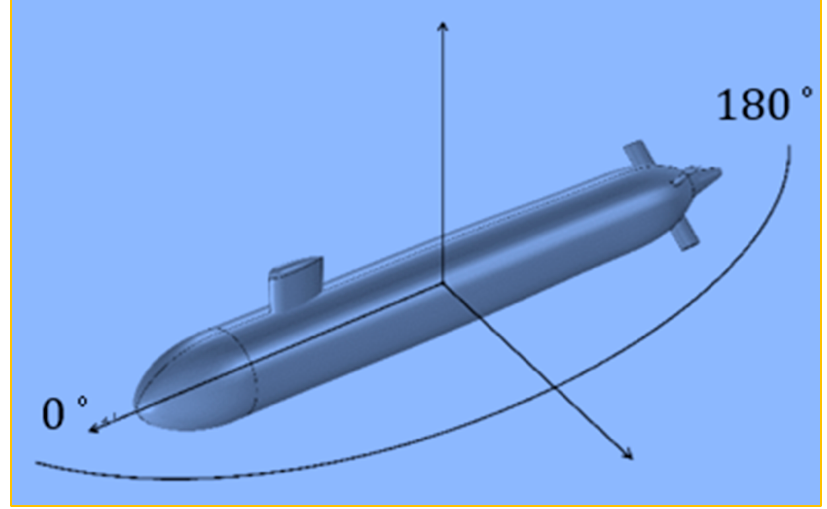
Figure 2. The simulation’s zoomed-out view of the target’s vitality and its sweeping angle. Target strength was calculated using the Helmholtz–Kirchhoff Integral [26,27] and the finite element technique (FEM) for the acoustic–solid coupled model. Target strength is defined by measuring the incident and reflection intensity ratio, and the reference dis- tance is “1 m” in front of the target’s reflection center [28–30]. Simple acoustic fields can be obtained using the wave equation and the Helmholtz equation, but a more complex geometrical model, considering underwater habitats’ boundary conditions, is required to obtain the proper underwater setting [31–33]. This work uses the finite element method (FEM) in conjunction with the governing equation in acoustic–solid connected modules to solve this complicated computation [34–36]. 3. Design Model and Methodology We used COMSOL Multiphysics, version 5.6, in this investigation to simulate the target strength computation. The parameters for performing the simulation are detailed below. Variables evaluated were the target model, vehicle shape, hull thickness, fre- quency, and sweeping angles of incident acoustic waves. The submarine geometry of BeTSSi is shown in Figure 3. Figure 3. Submarine geometry of BeTTSi.